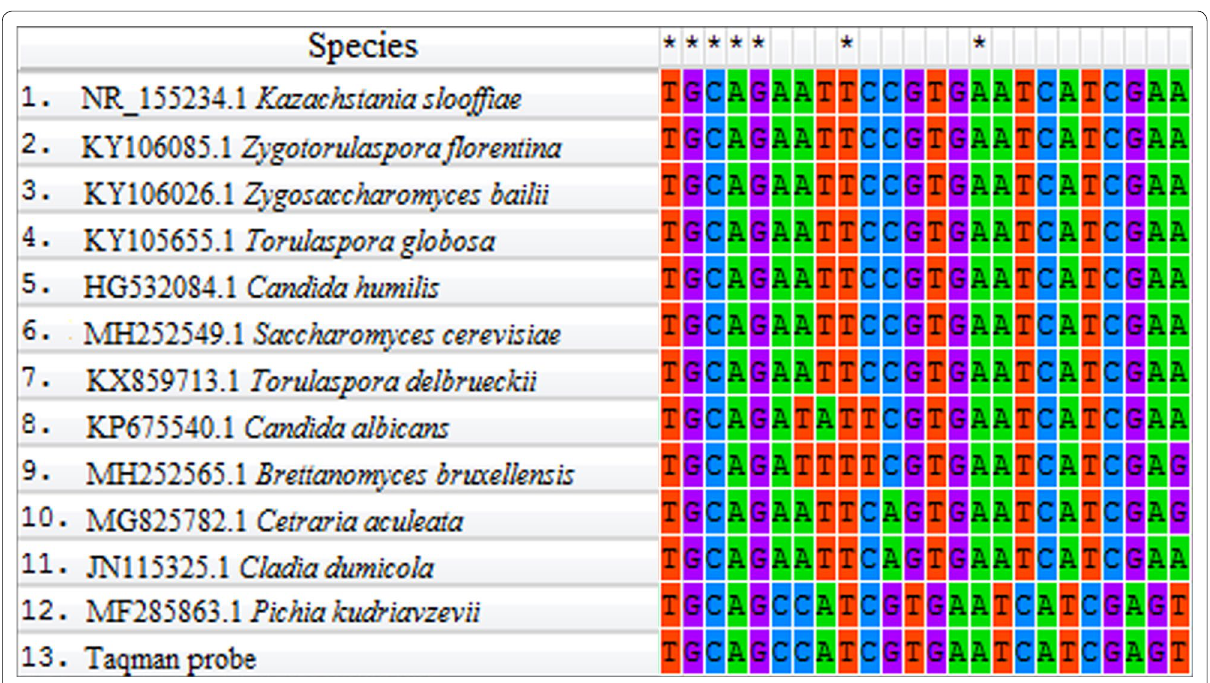
Fig. 1 Homologous sequences of the P. kudriavzevii DNA and DNA of other closest eukaryotic